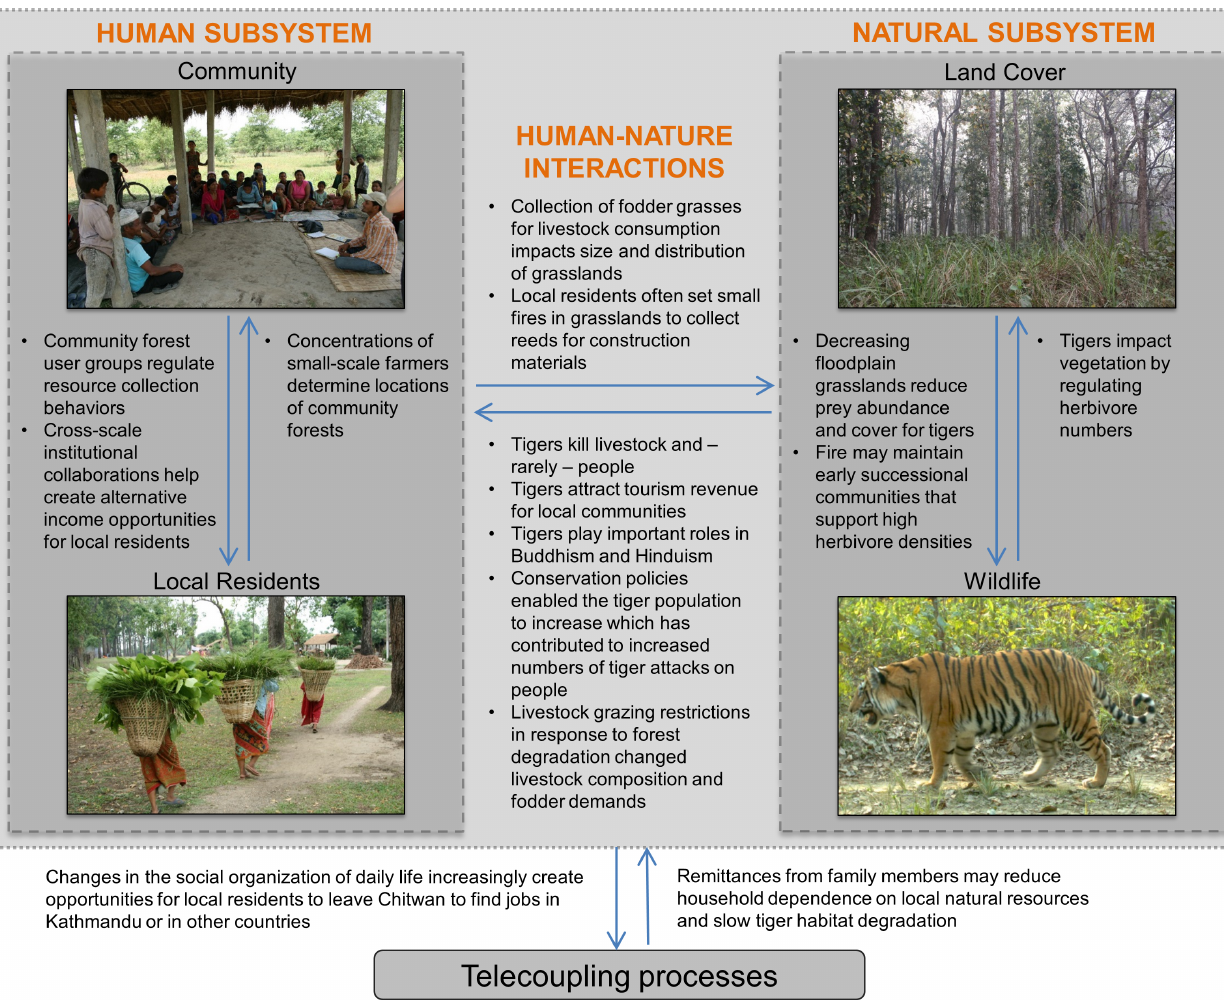
Fig. 5. Illustration of relationships within the human and natural subsystems as well as human-nature interactions that are important to understanding and conserving Bengal tigers in Chitwan National Park, Nepal. Relations are shown using a general coupled human and natural systems (CHANS) framework (see Fig. 1), and are not exhaustive or constant over time and across space. We encourage future research and conservation efforts to use this CHANS approach to continue filling in important information gaps in this and other sites where people and wildlife interact in complex